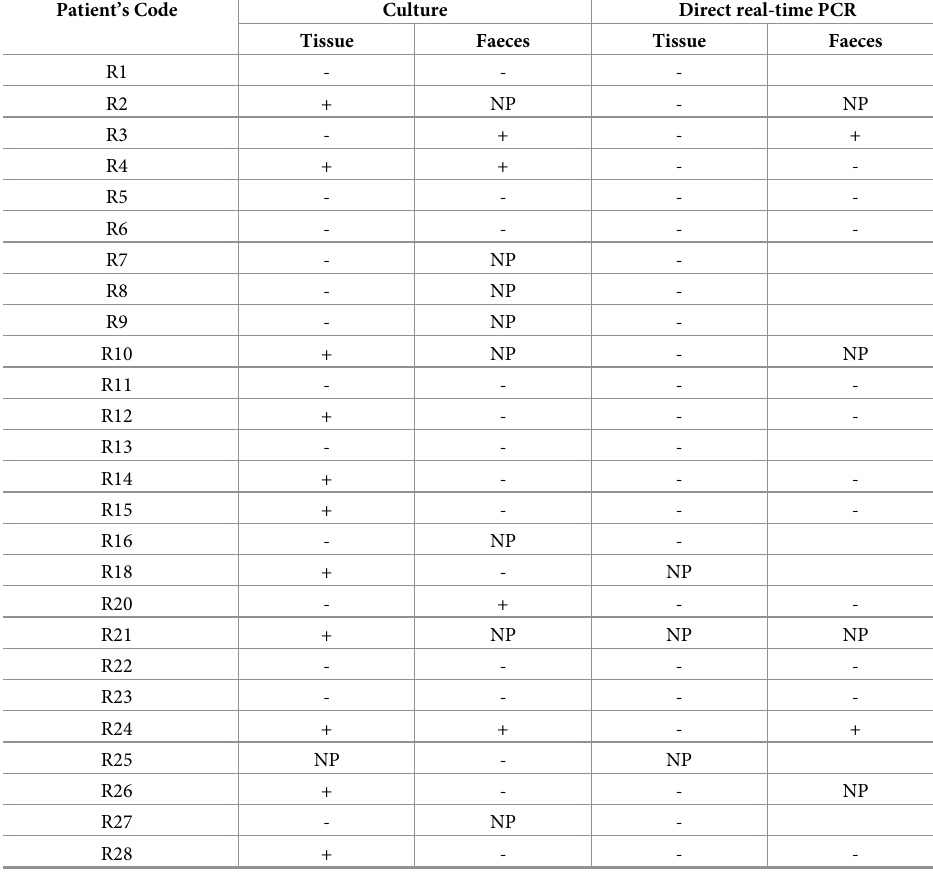
Table 1. Positivity to Mycobacterium avium subsp. paratuberculosis in samples of recruited patients with gastroin- testinal diseases in a GI centre Sudan (July 2019-Feb